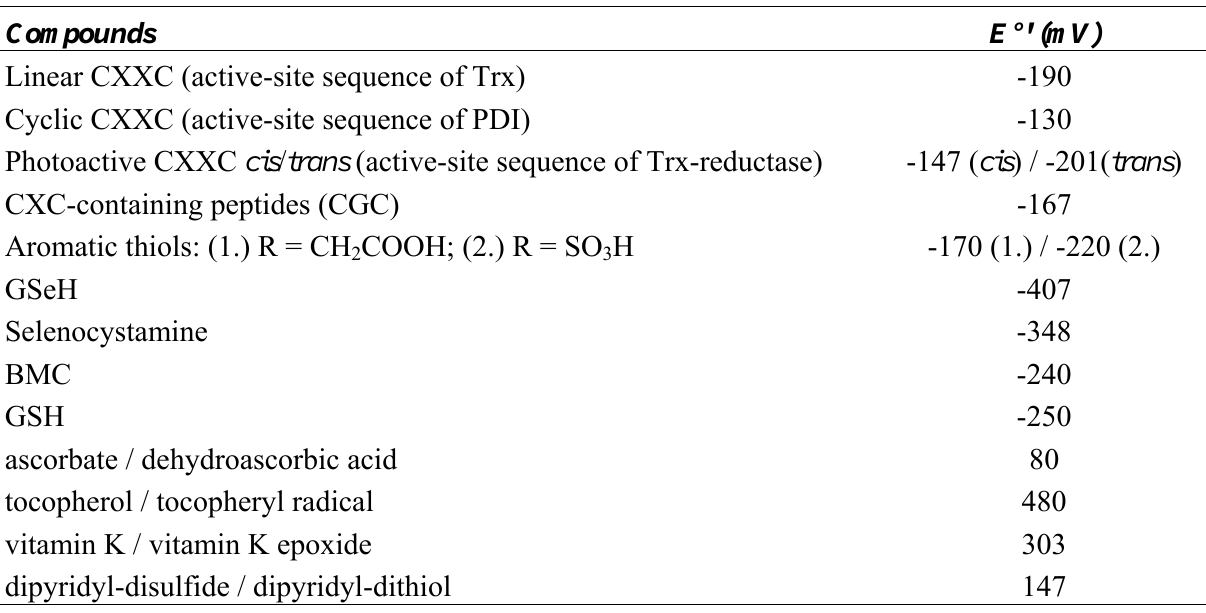
Table 1. The standard redox potentials of small-molecule catalysts of oxidative protein